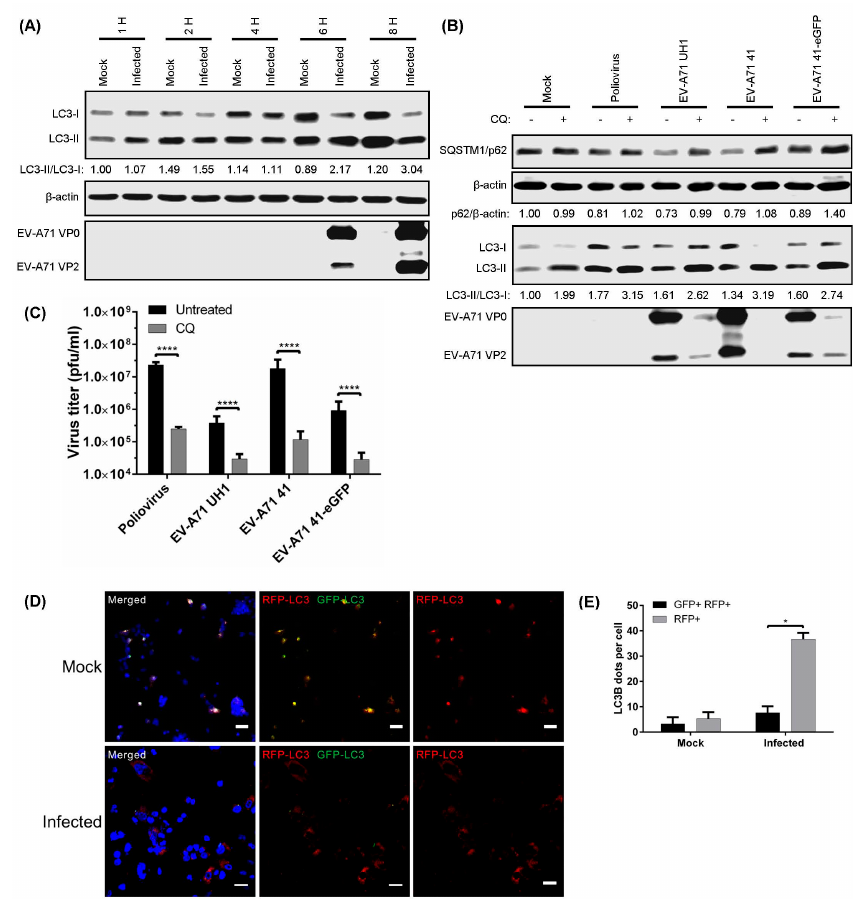
Figure 1. Acidic autolysosome formation triggered by enterovirus A71 (EV-A71) facilitates viral replication. Rhabdomyosarcoma (RD) cells were infected with EV-A71 (multiplicity of infection (MOI) = 10) up to various time points; then, ( A ) microtubule-associated protein 1 light chain 3 (LC3) and viral proteins were detected by Western Blot (WB). RD cells were infected with either poliovirus (PV), EV-A71 strain UH1, EV-A71 strain 41, or EV-A71 41-eGFP reporter (MOI = 10) and treated with 50 µM CQ from 1 hpi to 8 hpi; then, cell lysates were collected to determine ( B ) the sequestosome-1 (SQSTM1)/ β -actin and LC3-II/LC3-I ratios by WB; and ( C ) viral titres; ( D ) RD cells were transduced with baculovirus bearing tandem RFP-GFP-LC3 for 72 h, and infected with EV-A71 for 8 hpi; then, a confocal microscope was used to detect RFP and GFP signals. Scale bar, 30 µM; ( E ) The amounts of GFP and RFP dots of LC3B per cell were determined for mock– and EV-A71-infected RD cells. Error bars, means ± SD of 3 independent experiments. One-way and two-way ANOVA or Student’s t -test: * p < 0.05, ** p < 0.01, and **** p < 0.0001.